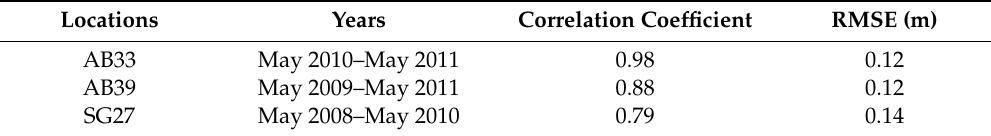
Table 2. Comparison of snow estimates from L2P SNR and in situ